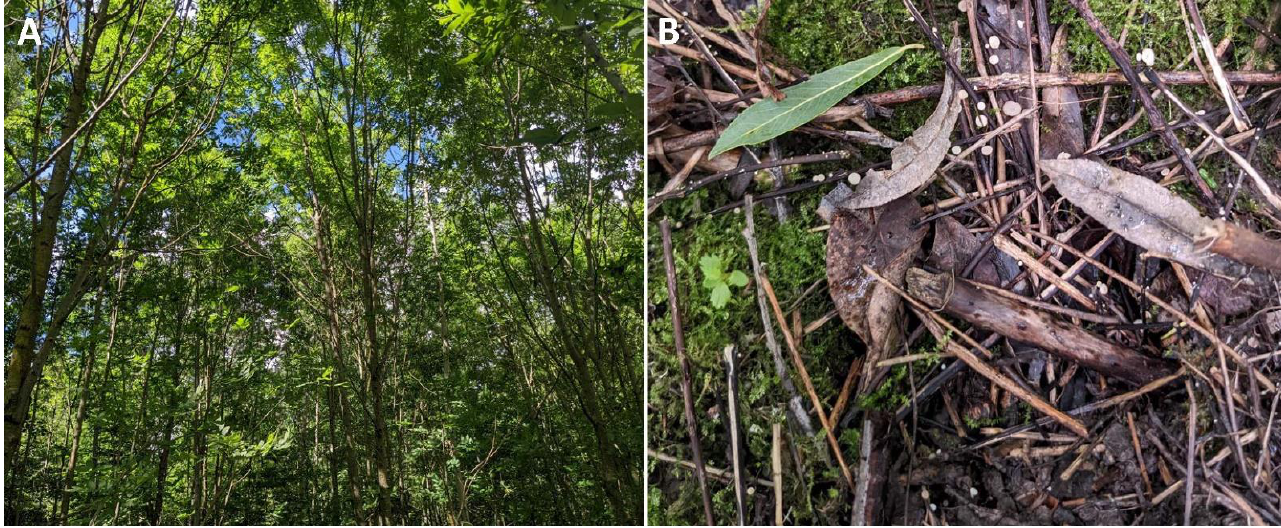
Figure 1. ( A ) Naturally re-emerged Fraxinus excelsior stand (site U2); ( B ) Hymenoscyphus fraxineus fruiting bodies on ash petioles at the U2 site.